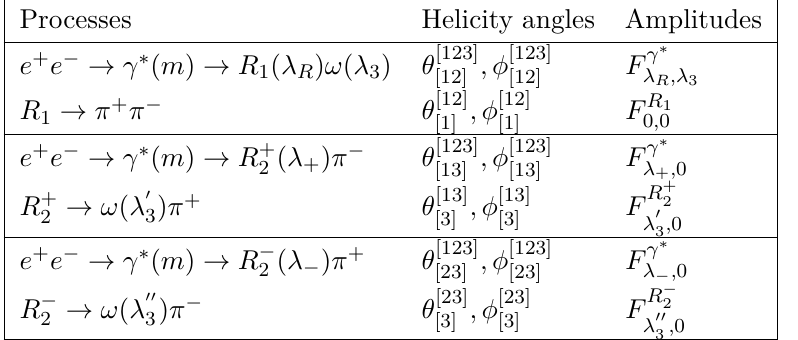
Table 1 . Definitions of helicity angles and amplitudes for sequential processes (a), (b), and (c). Here, λ and m denote the helicity values for individual particle and the spin z projection of virtual i photon in electron-positron